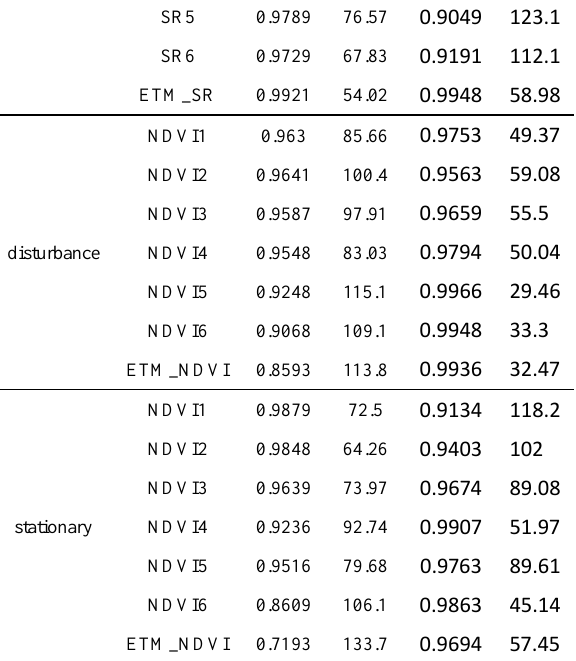
Table 3: 6 optimal linear models and non-linear models